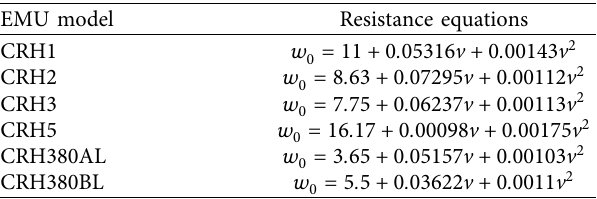
Table 3: Basic resistance equations and parameters of common EMUs per unit weight.